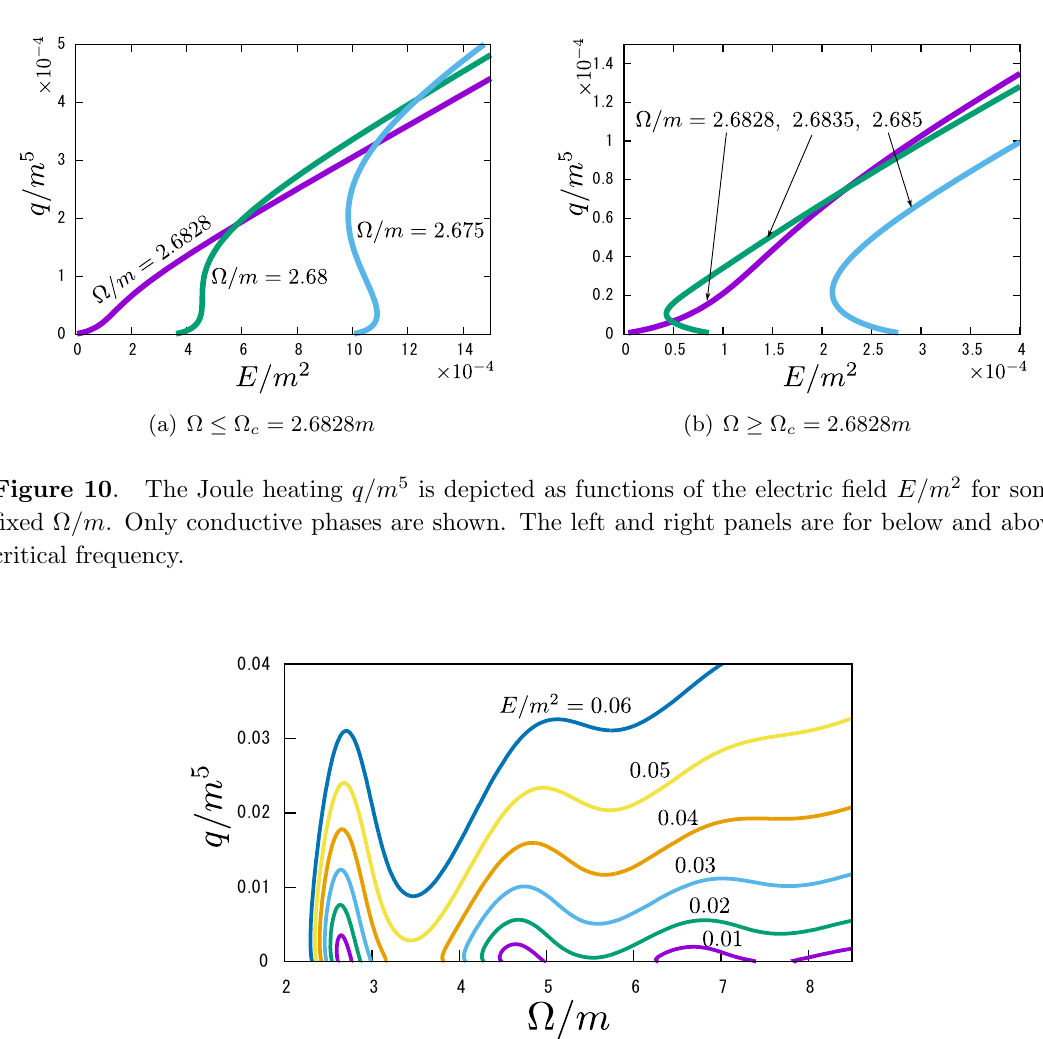
Figure 11 . Joule heating for (cid:12)xed electric